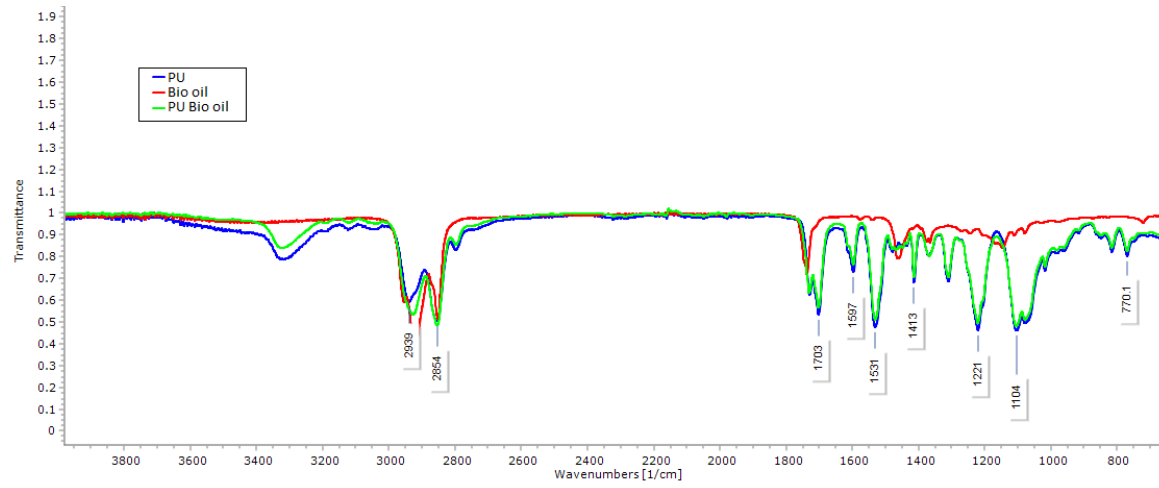
Figure 2 - FTIR analysis of pure PU, bio oil TM and PU/bio oil TM